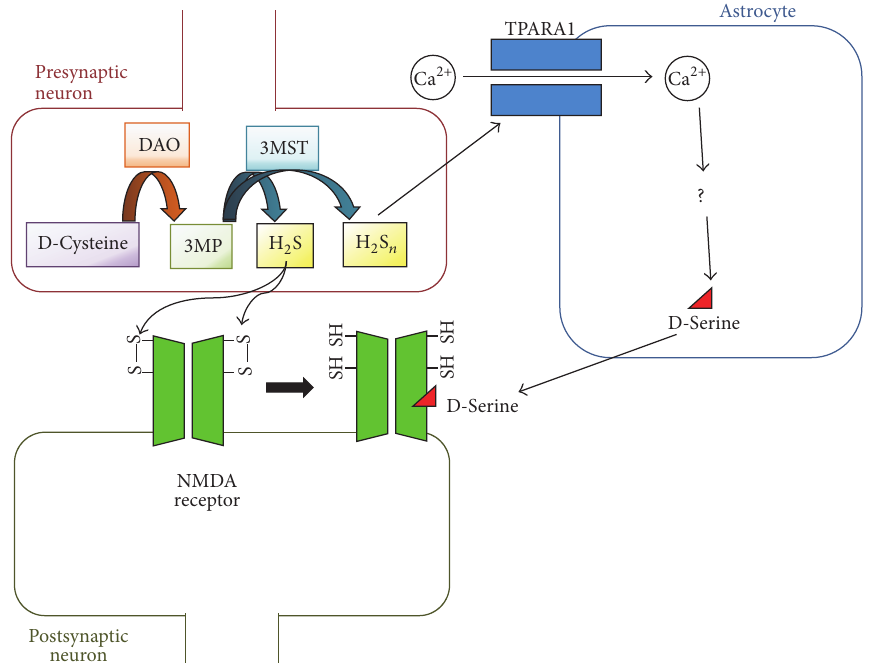
Figure 2: Activation of the N-methyl-D-aspartate (NMDA) receptor by D-cysteine. D-Cysteine is one of the sources of H 2 S in the brain. D-Cysteine is converted to 3-mercaptopyruvate (3MP) by D-amino acid oxidase (DAO). 3MP is then degraded by 3-mercaptopyruvate sulfurtransferase (3MST) to generate H 2 S in the neurons. Hydrogen polysulfides (H 2 S 𝑛 ; 𝑛 = 2 –5) are also generated by 3MST from 3MP. H 2 S reduces the disulfide bonds in the NMDA receptor and increases the activity of the NMDA receptor. H 2 S 𝑛 also activates the transient receptor potential (TRP) A1 channel. Activated TRPA1 channel induces Ca 2+ influx, leading to D-serine release in astrocytes, and D-serine then activates the NMDA